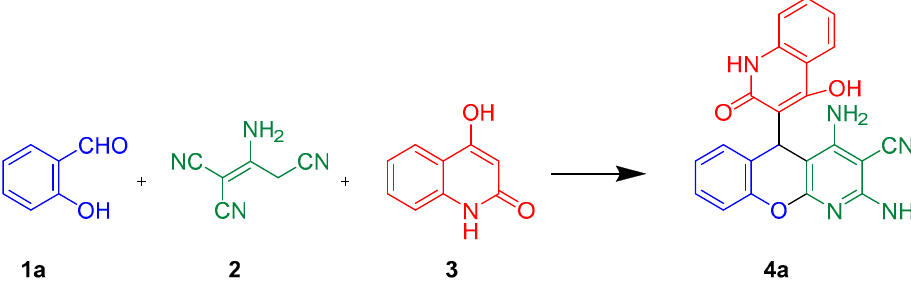
Scheme 1. Reaction of salicylaldehyde, malononitrile dimer and Table 1. Optimization of reaction conditions 1 .